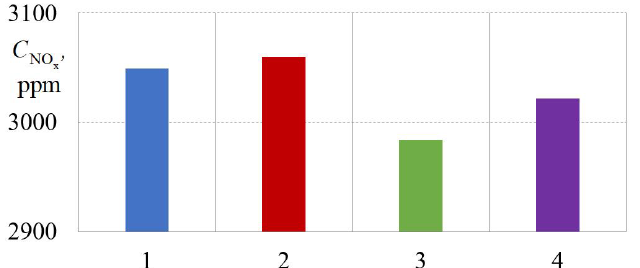
Figure 16. Diagrams of NOx concentration values in the exhaust gases of the engine at nominal mode for the intake system with channels of different diameters: 1— d = 20 mm; 2— d = 32 mm; 3— d = 40 mm; 4— d = 50 mm.